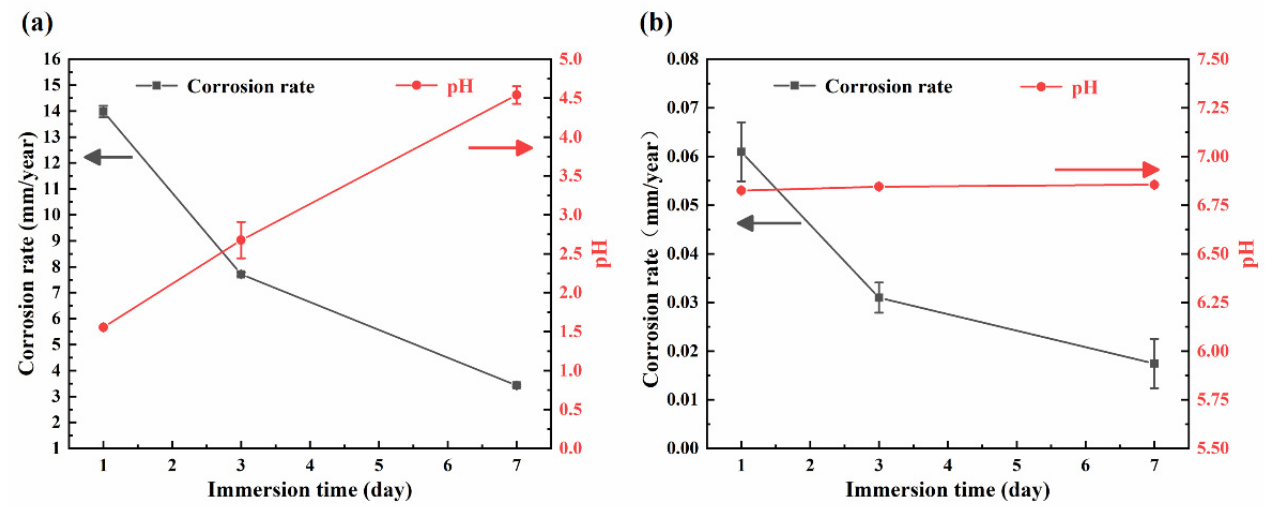
Figure 2. Corrosion rate and pH of Zn–0.4Li immersed in SGF and SIF at different times: ( a ) in SGF and ( b ) in SIF.